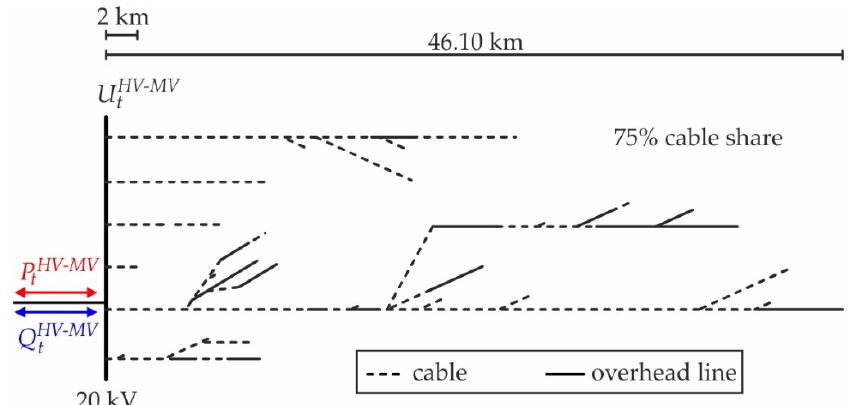
Figure 9. Simplified one-line diagram of the MV grid.